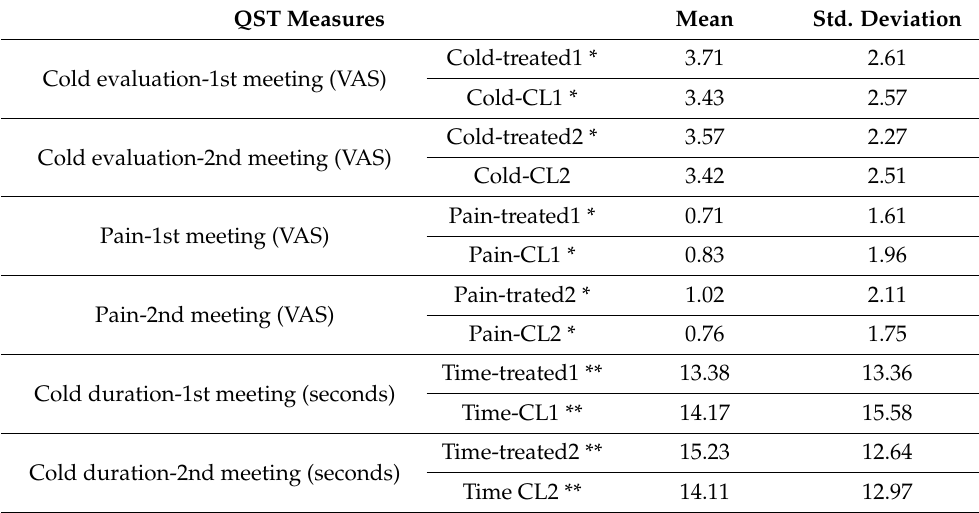
Table 2. Mean scores of the QualST pain, cold, and cold duration tests.